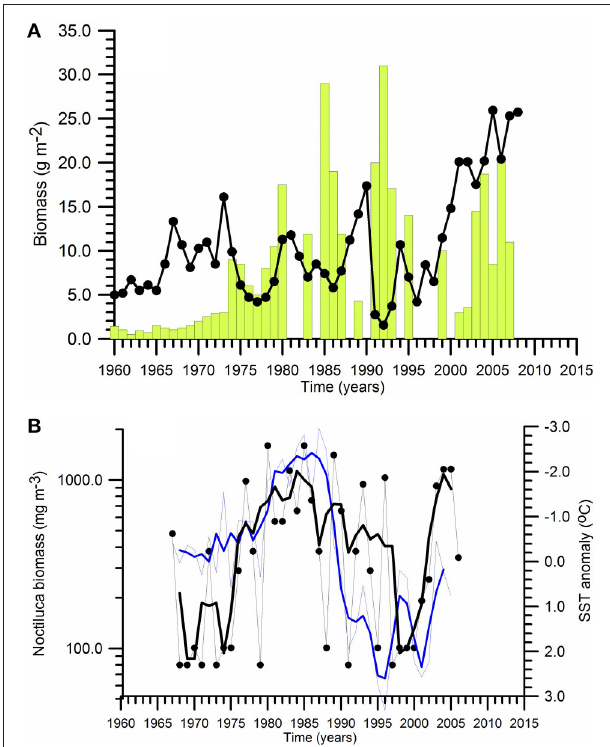
FIGURE 7 | Temporal variations of (A) summer-autumn mean phytoplankton biomass integrated over the euphotic zone (vertical bars), and zooplankton biomass ( • ) for the northeastern part of the Black Sea, (B) Noctiluca scintillans biomass ( • ) and annual-mean SST variations at the coastal station Galata along the Bulgarian